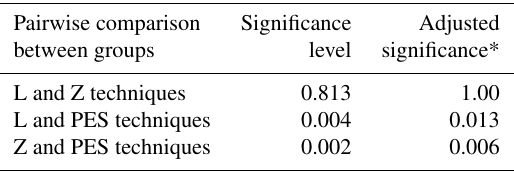
Table 2. Quantitative results in pairwise